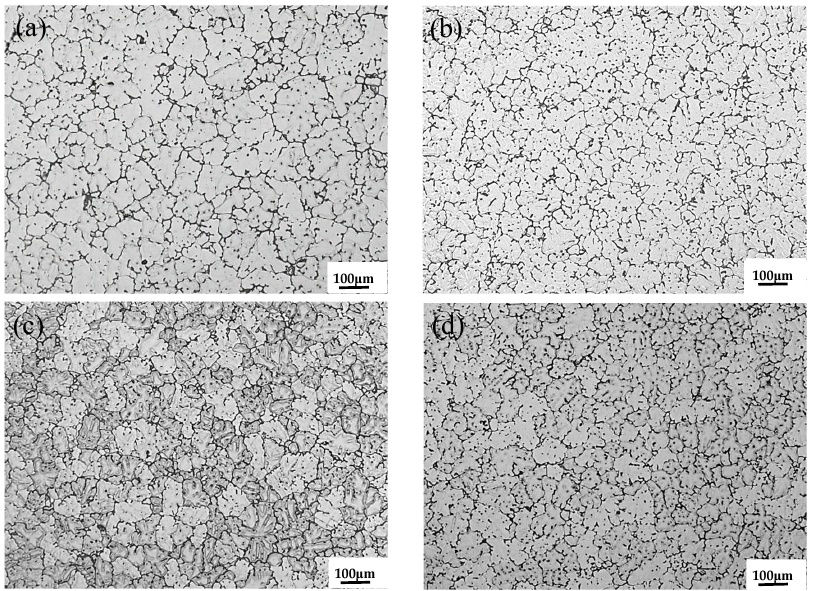
Table 1. High-temperature aging process of ZL205A alloy.